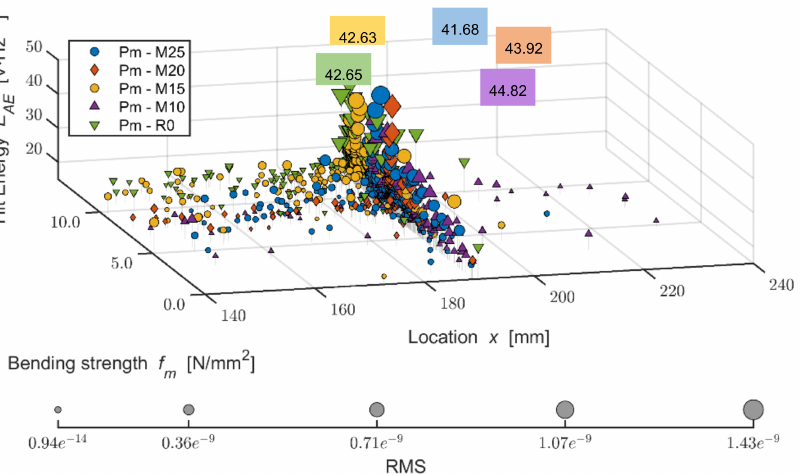
Figure 23. Comparison of bending strength and defects development (hit energy with maximum; larger points = higher RMS) during static mechanical load in the monitored area of test speci- mens; mixture PM (boards modified by particle mixture PM) before and after frost/defrost cycles: x = 190 mm—middle of the